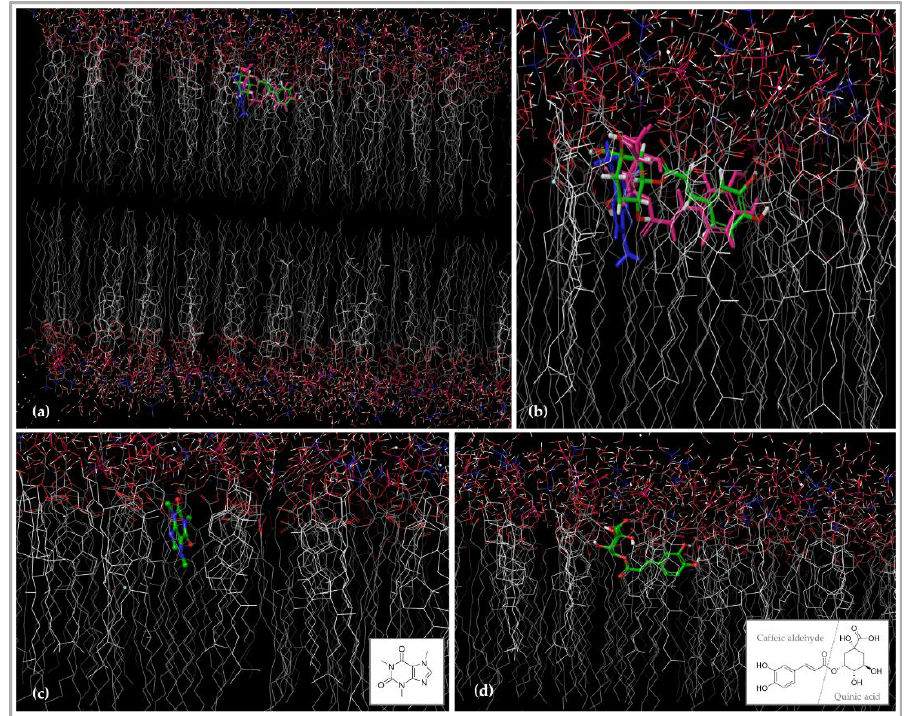
Figure 7. Simulated 3D model of the cholesterol-incorporated nano-phytosome bilayer docked with main phytochemicals of SI (caffeine and 5-caffeoylquinic acid). The lipid bilayer appears spherical (see also Figure 4). ( a , b ) show an overlap of the compound’s interaction with the lipid bilayer. ( c ) Caffeine (purine alkaloid); adjusted near a polar size with minimum rate of hydrogen binding. ( d ) 5-Caffeoylquinic acid; the majority of hydrogen binding occurred due to both caffeic aldehyde and quinic acid